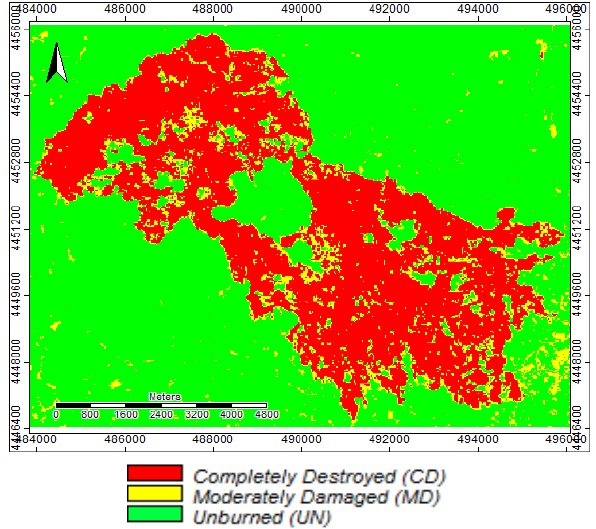
Figure 5. The result of FLS classification